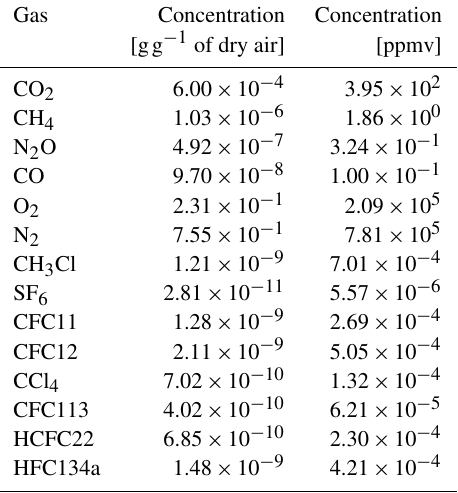
Table 4. Concentration of WMGHGs and minor gases used for the simulation. The concentrations of all these gases are assumed to be vertically